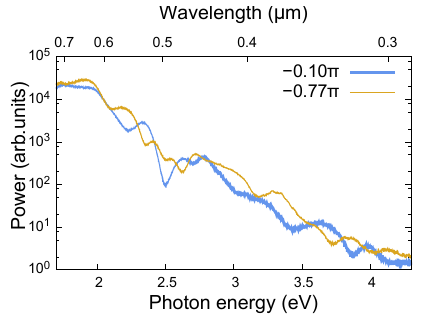
Figure 2. The HH spectra generated by the sub- cycle MIR pulses shown in Fig.